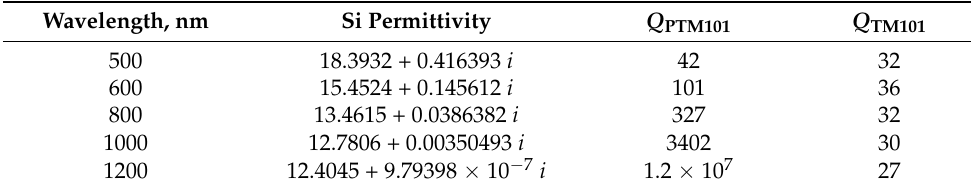
Table 1. Q factors of the PTM 101 and TM 101 modes in the Si sphere. Wavelength, nm